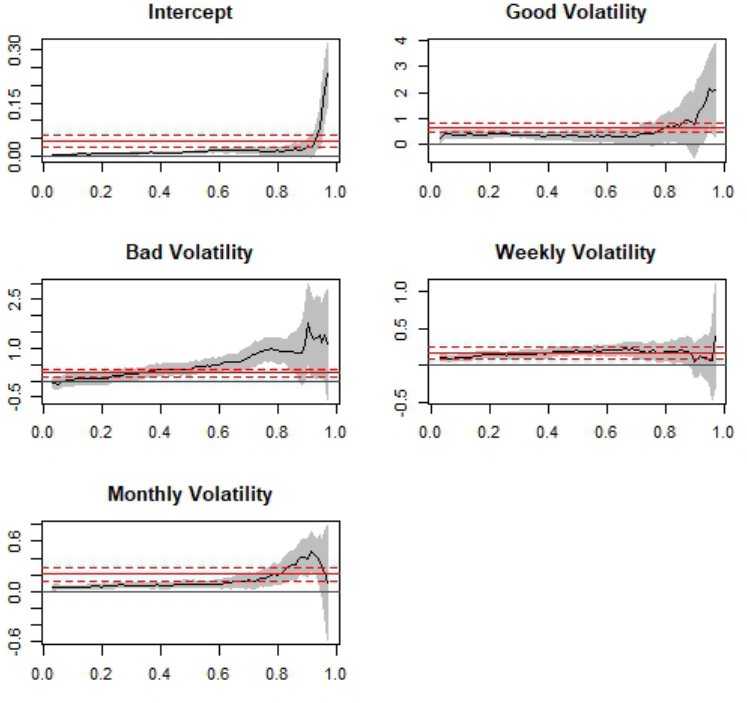
Figure 2. Model 2: HAR-RV-QR results—1-day